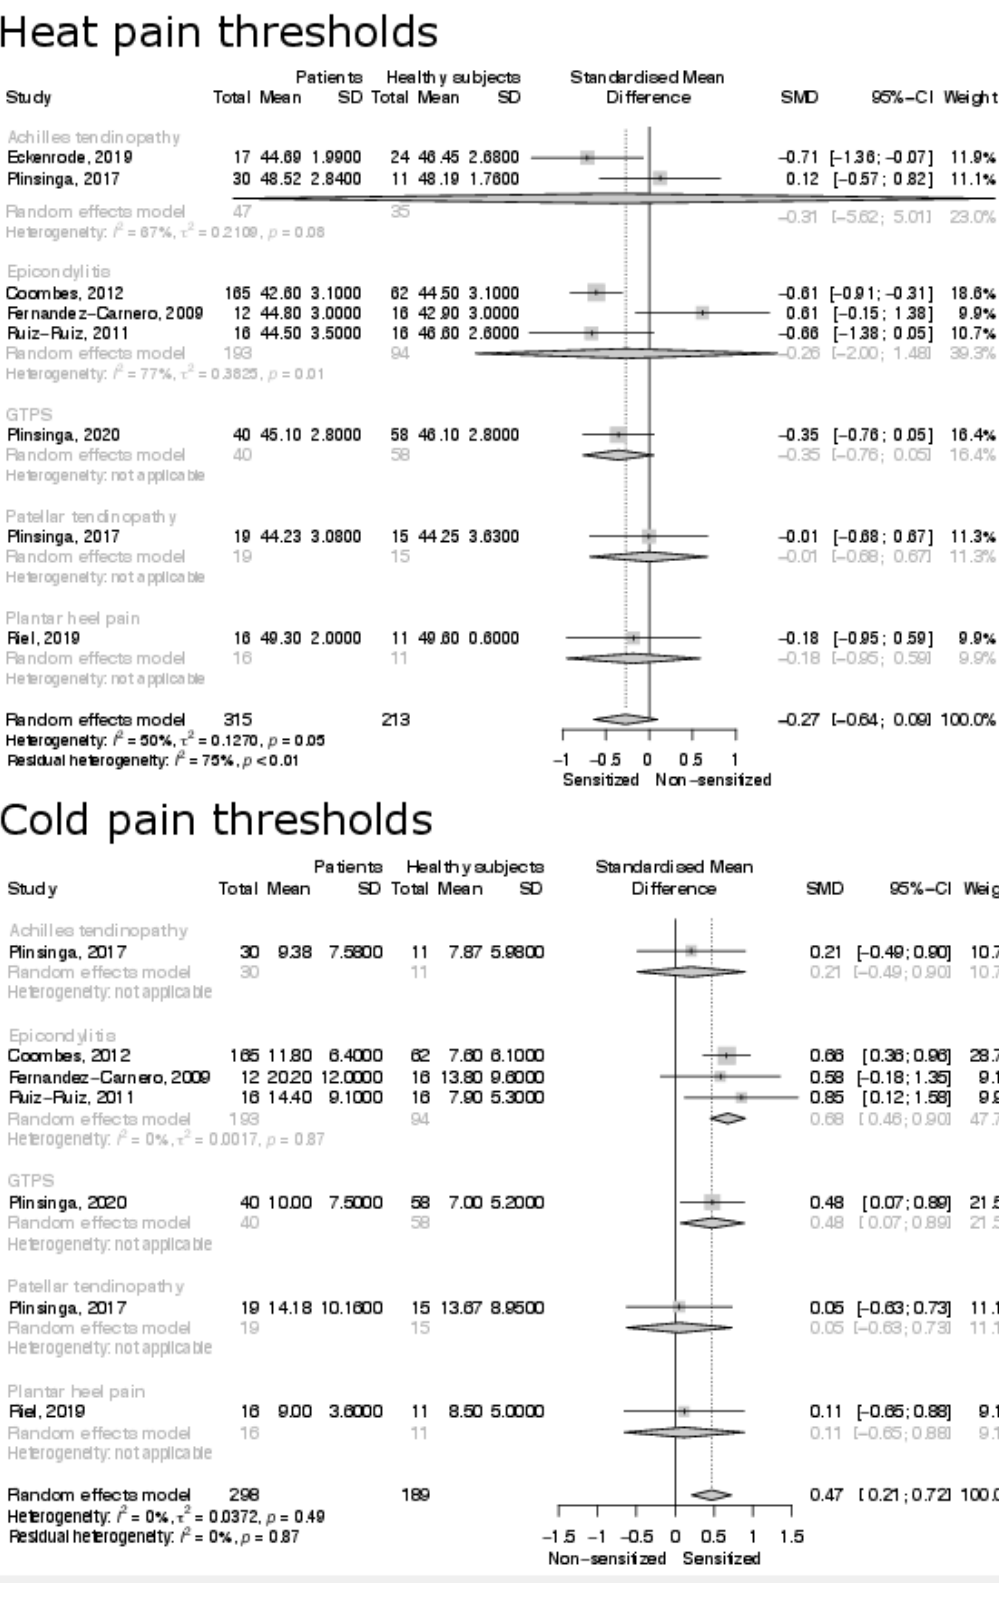
Figure 3. Results of the meta-analysis on local heat and cold pain thresholds.